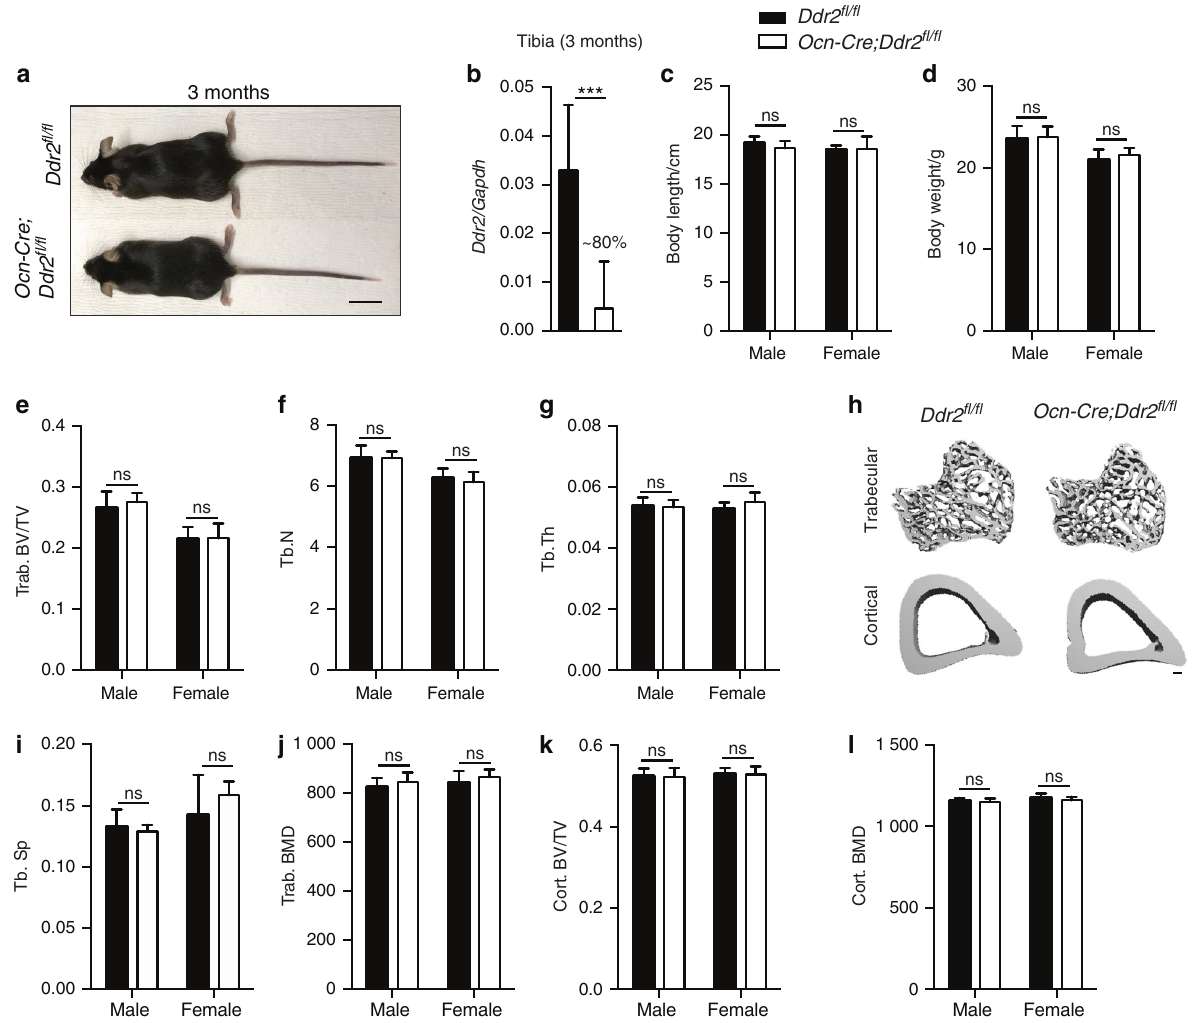
Fig. 7 No obvious bone defects with osteoblast speci fi c Ddr2 knockout. a Gross phenotype of 3 month-old Ddr2 fl / fl and Ocn-Cre;Ddr2 fl / fl littermates. Ocn-Cre;Ddr2 fl / fl mice have no skeletal phenotype ( n = 20, 10 mice/sex). Scale bar, 2 cm. b Gene expression analysis of Ddr2 from whole 3 month-old tibiae to con fi rm knockout ef fi ciency ( n = 8 mice). c , d Measurements of body length (cm) and weight (g) ( n = 20, 10 mice/ sex), unpaired t -test. ns Not signi fi cant. e – j Quantitative data of trabecular bone volume fraction (Trab. BV/TV), trabecular number (Tb.N), trabecular thickness (Tb.Th), trabecular spacing (Tb.Sp) and bone mineral density (Trab. BMD), ( n = 20, 10 mice/sex). h 3D micro-computed tomography (microCT) models of the tibial metaphysis and cortical mid-shaft in 3 month-old Ddr2 fl / fl and Ocn-Cre; Ddr2 fl / fl mice. Scale bar 100 µm. k , l Quanti fi cation of cortical bone volume fraction (Cort. BV/TV), and bone mineral density (Cort. BMD). ( n = 20, 10 mice/sex), unpaired t -test, ns Not signi fi cant. Data were presented as mean ±